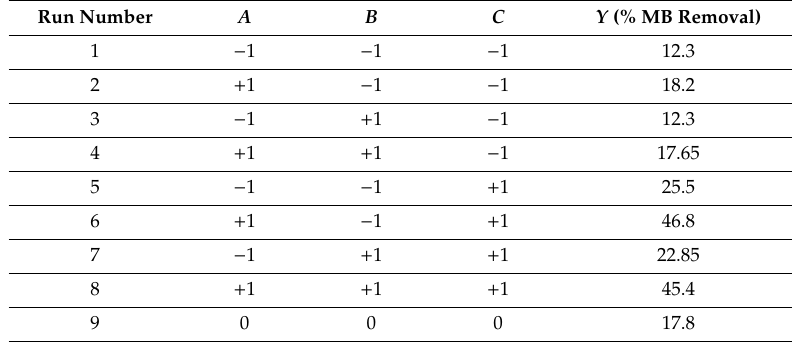
Table 3. Full factorial (2 3 ) experimental